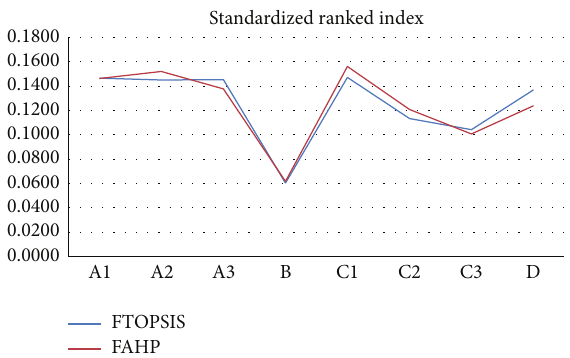
Figure 5: Comparison of vibration analyser results from FAHP and